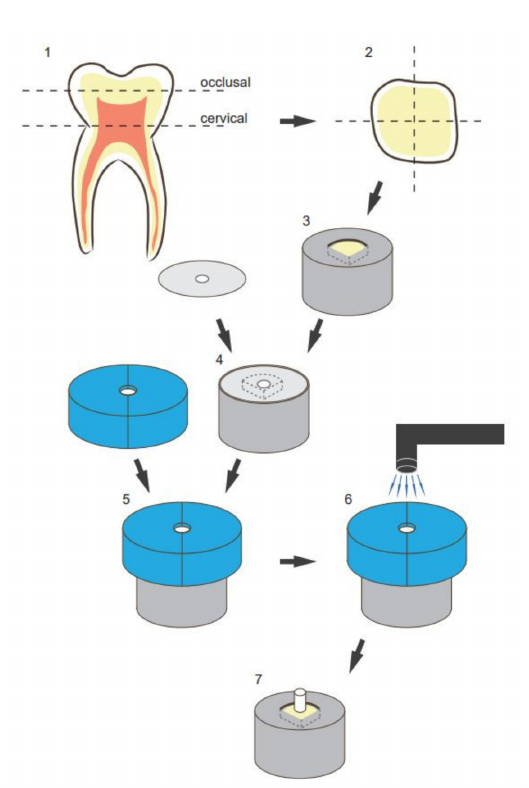
Figure 1. Illustration of sample preparation and bonding procedure: ( 1 ) schematic presentation of the cutting procedure; ( 2 ) schematic presentation of the cross-section of each tooth half; ( 3 ) embedding of the dentin substrate in methacrylic resin; ( 4 ) placement of the adhesive paper (with a centered circle-round hole; diameter of 3.16 mm) on the specimen to limit the bonding area; ( 5 ) placement of the vinyl polysiloxane split mold with a cylindric cavity (diameter of 3.16 mm and height of 4 mm); ( 6 ) schematic presentation of the resin–composite placement and light curing; and ( 7 ) restored final